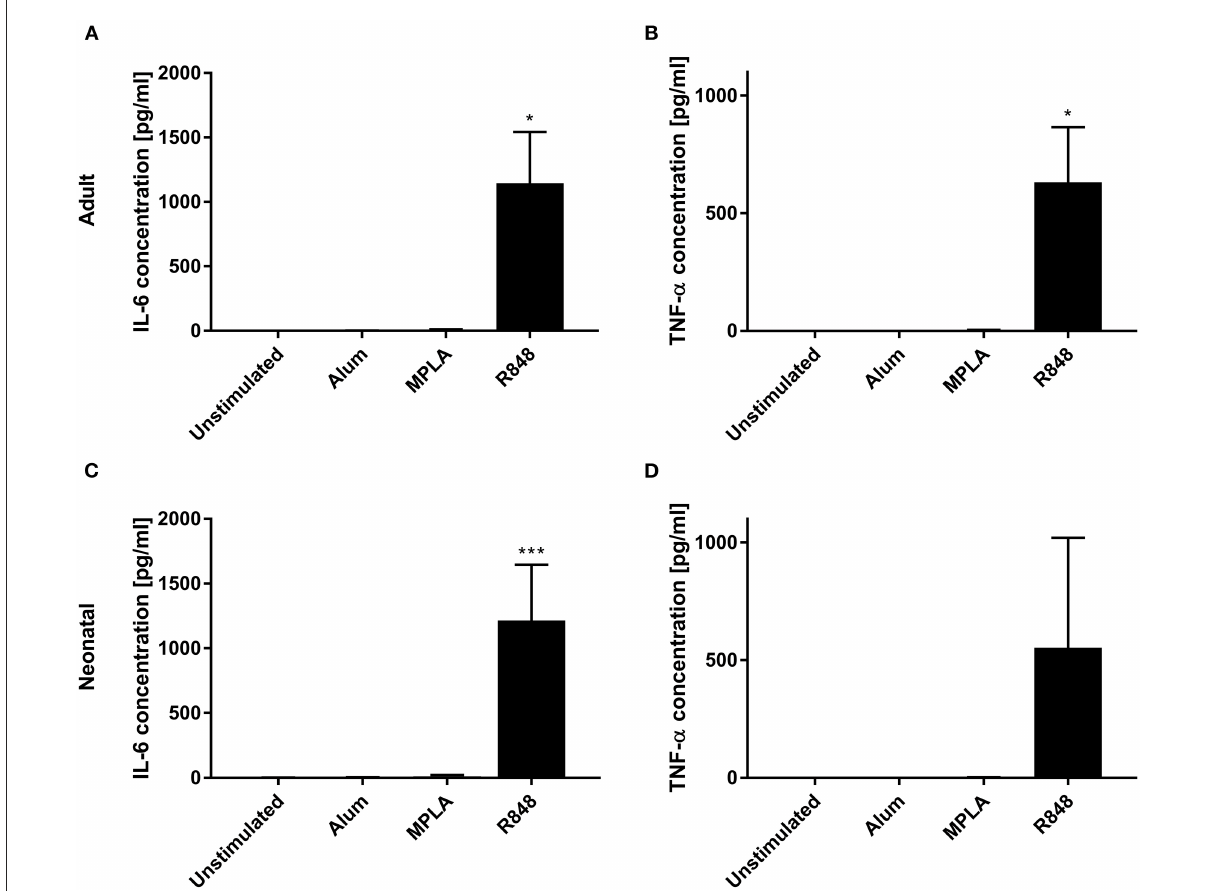
FIGURE3 Effect of different adjuvants on DC cytokine secretion. Analysis of IL-6 (A,C) and TNF- α (B,D) secretion by adult (A,B) and neonatal (C,D) DCs after incubation with or without alum, MPLA or R848 for 20h. Data represent the means ± SD ( n = 3). Significantly more than unstimulated: * P < 0.05; *** P < 0.005 [ (A,B) one-way ANOVA; (C,D) Kruskal-Wallis